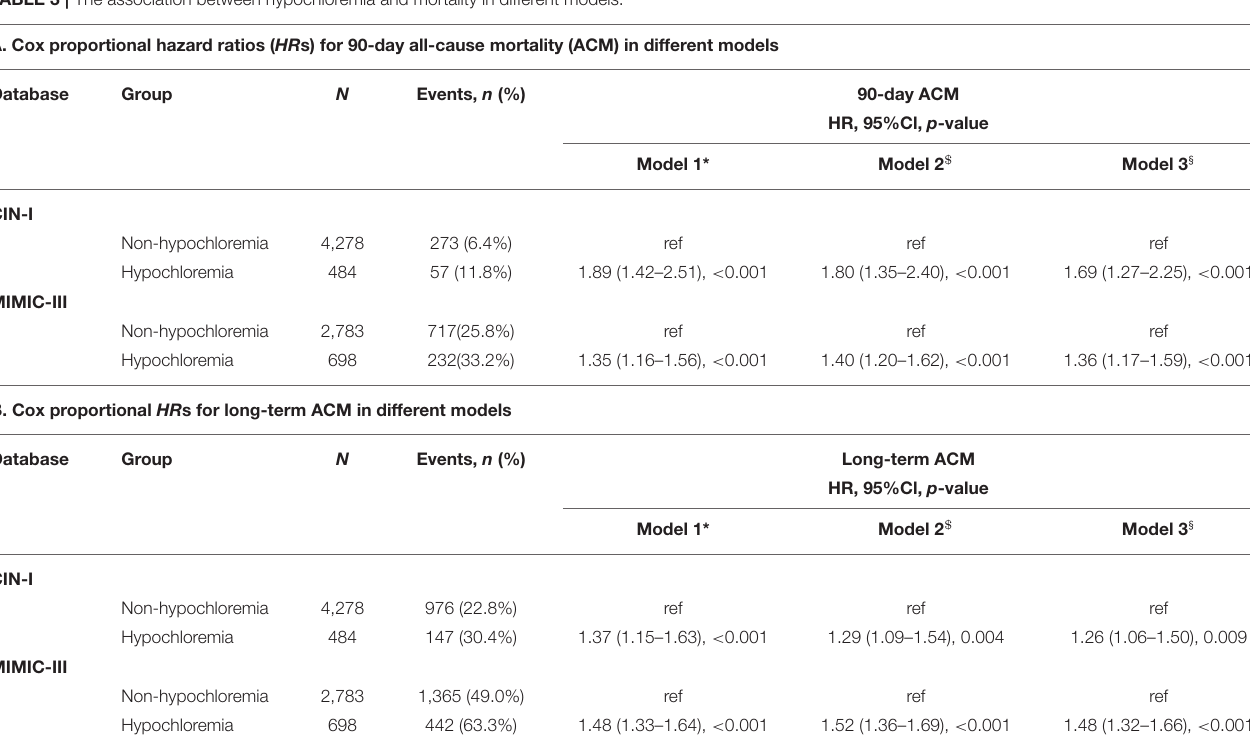
TABLE 3 | The association between hypochloremia and mortality in different